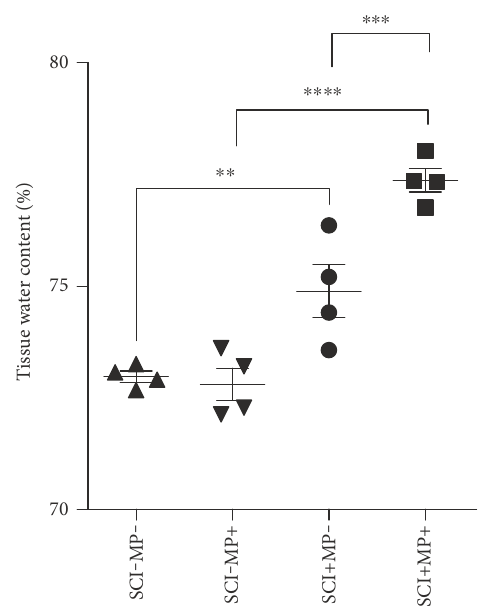
Figure 3: Spinal edema is increased following MP administration. Water content of spinal cord tissues was calculated in 1cm long segment of the spinal cord at the site of injury. Graph shows statistical mean ± SEM. Each point in the graph shows the percentage of water per spinal cord ( n = 4 per group). ∗∗ p < 0 01 ; ∗∗∗ p < 0 001 ; ∗∗∗∗ p < 0 0001